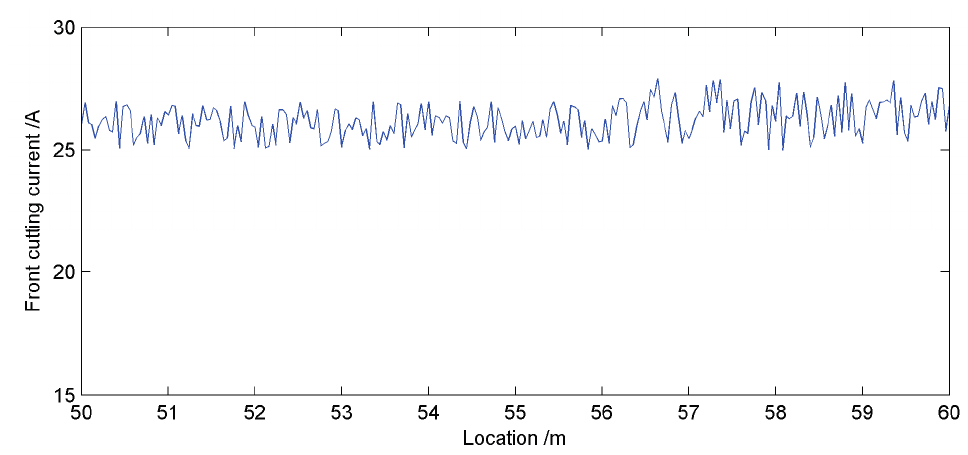
Figure 11. Change curve of shearer left cutting current from 50 m to 60